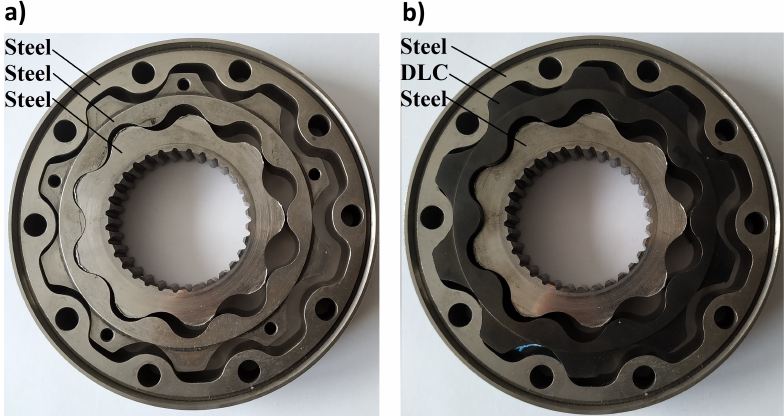
Figure 4. Materials of the most important mechanical parts of the ( a ) original and ( b ) modified hydraulic